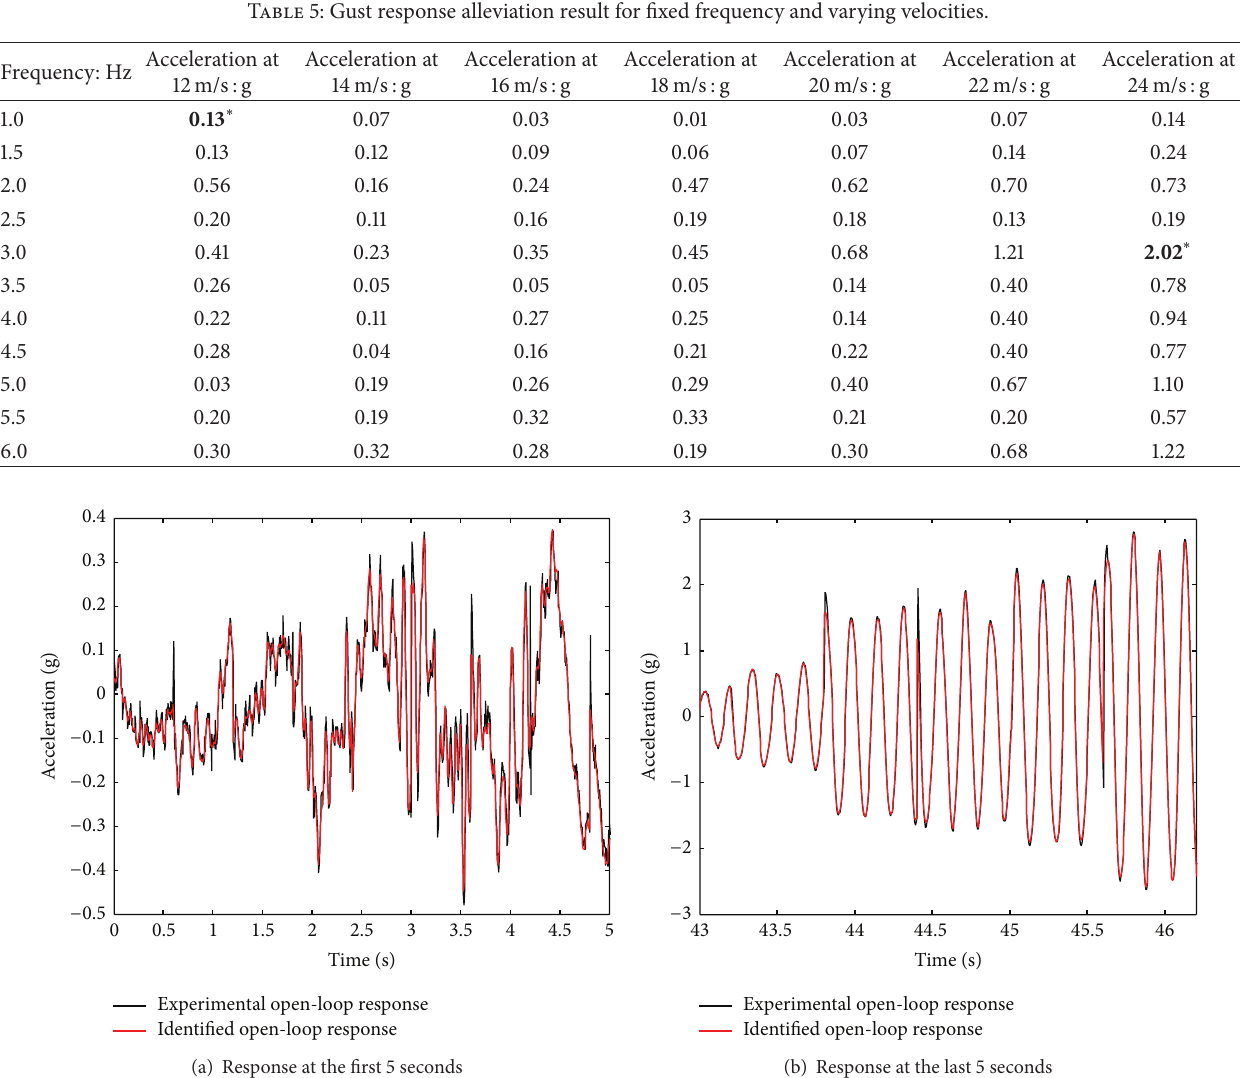
Figure 7: The comparison between the experimental response and the output of identified AR